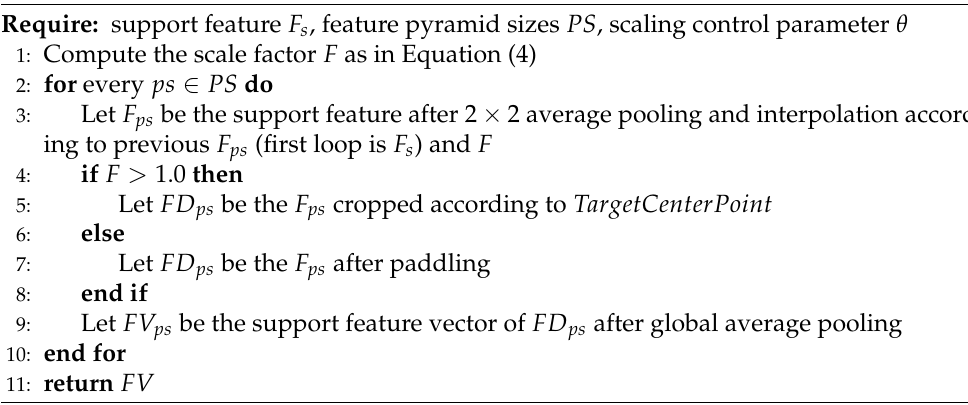
Figure 6. A visual illustration of multi-scale feature matching module, which includes two branches: zoom-in branch and zoom-out branch. circled + is a pixel-wise addition. The role of MFMM is to normalize the segmenting object scale according to Scale Factor F . Algorithm 1 Multi-Scale Feature Matching